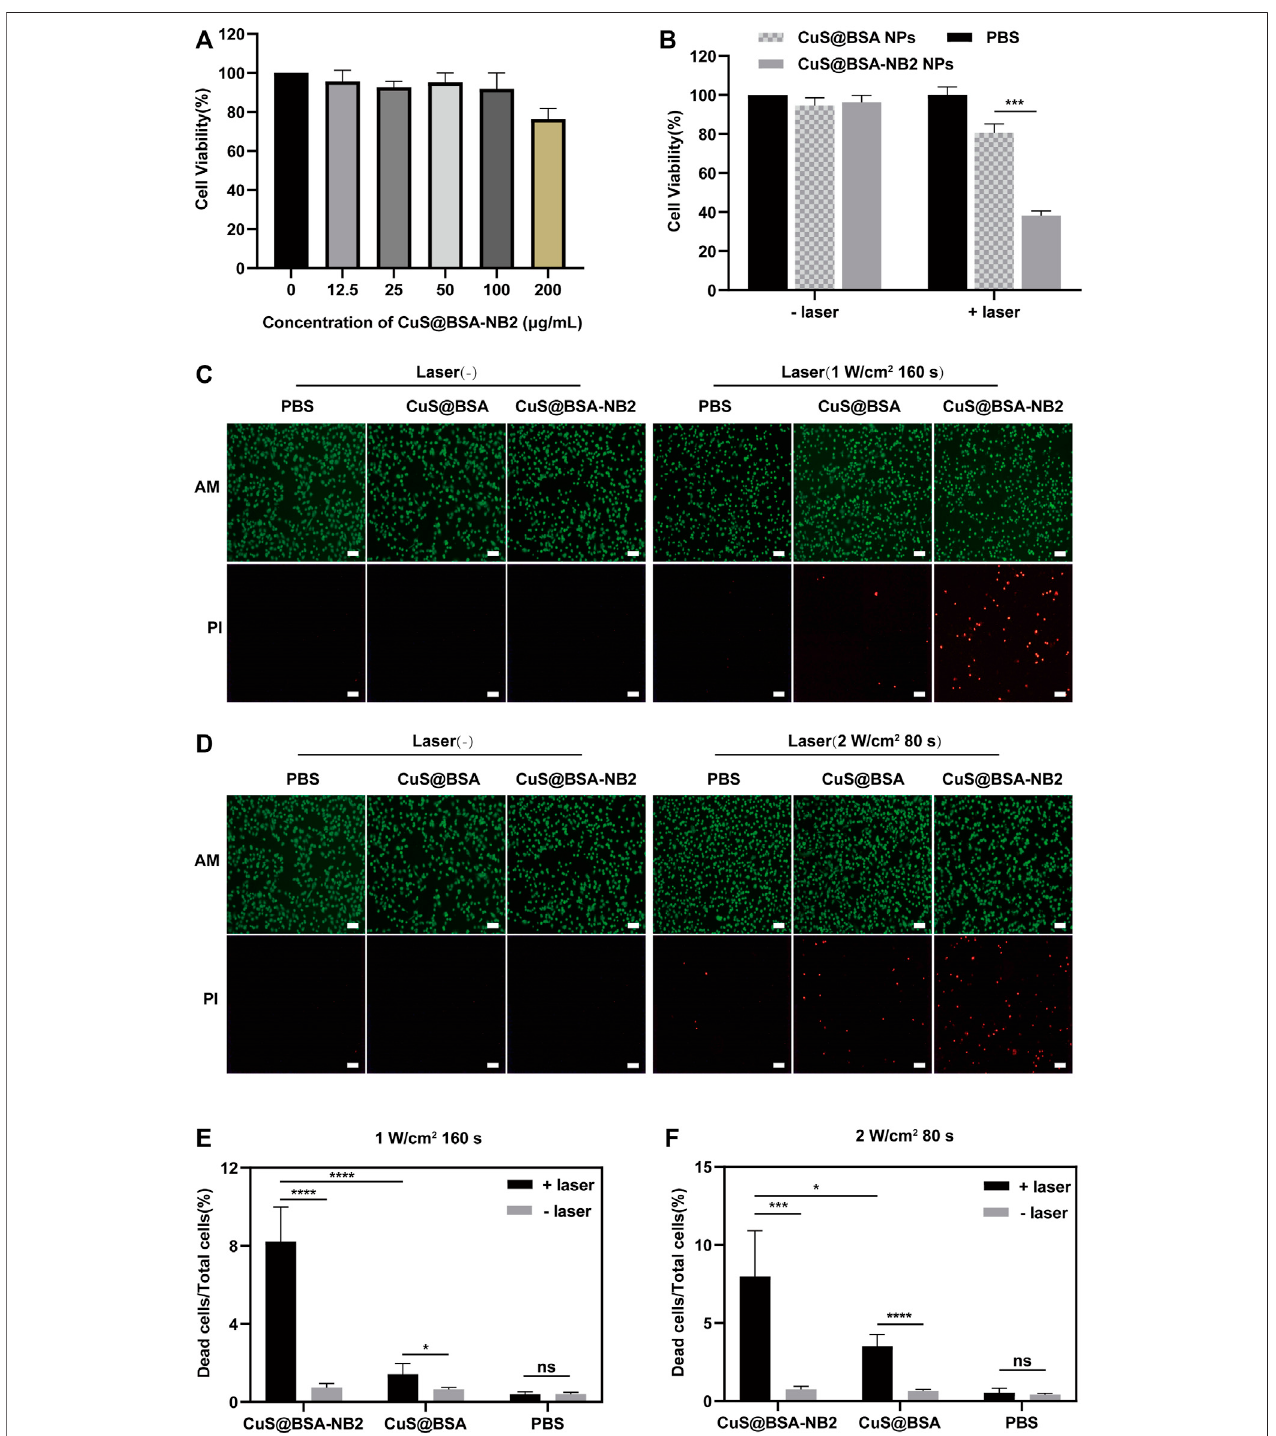
FIGURE 6 | The photothermal effect of CuS@BSA-NB2 nanoparticles in the cell. (A) The cytotoxicity measured by MTT of CuS@BSA-NB2 nanoparticles at different concentrations incubated in MDA-MB-231/HER2 cells ( n (cid:1) 3). (B) MTT assay detected the photothermal effect of MDA-MB-231/HER2 cells treated with 50 μ g/ml CuS@BSA-NB2NPs and CuS@BSA NPs under 808 nm (2 W/cm 2 , 80 s) ( n (cid:1) 3, *** p < 0.01). (C) Living and dead cells stained by AM and PI images ofMDA-MB- 231/HER2 cellstreatedwith50 μ g/mlCuS@BSA NPsandCuS@BSA-NB2NPsandirradiatedby808 nm(1 W/cm 2 ,160 s). Thescalebarwas100 μ m. (D) Living and dead cells stained by AM and PI images of MDA-MB-231/HER2 cells treated by 50 μ g/ml CuS@BSA NPs and CuS@BSA-NB2 NPs and irradiated under 808 nm (2 W/cm 2 , 80 s). The scale bar was 100 μ m. (E) The data statistical analysis chart of the proportion of dead cells to total cells of Figure C ( n (cid:1) 5, **** p < 0.01). (F) The data statistical analysis chart of the proportion of dead cells to total cells of Figure D ( n (cid:1) 5, * p < 0.01).